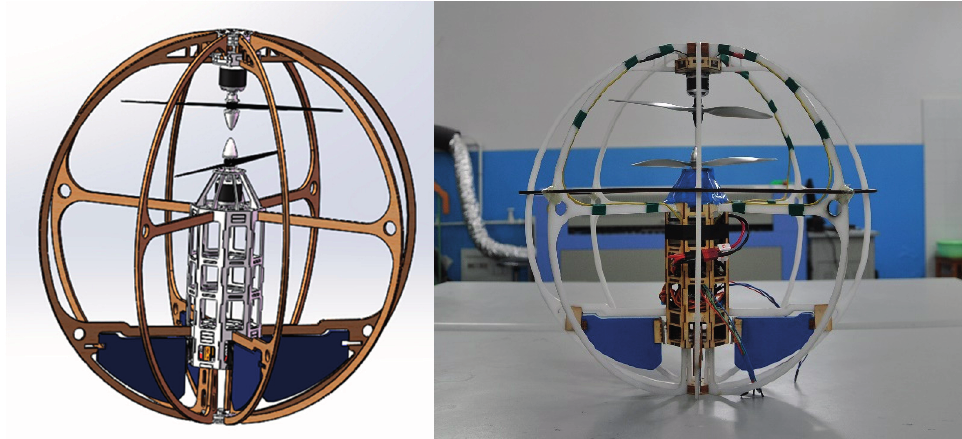
Figure 1. Miniature flying